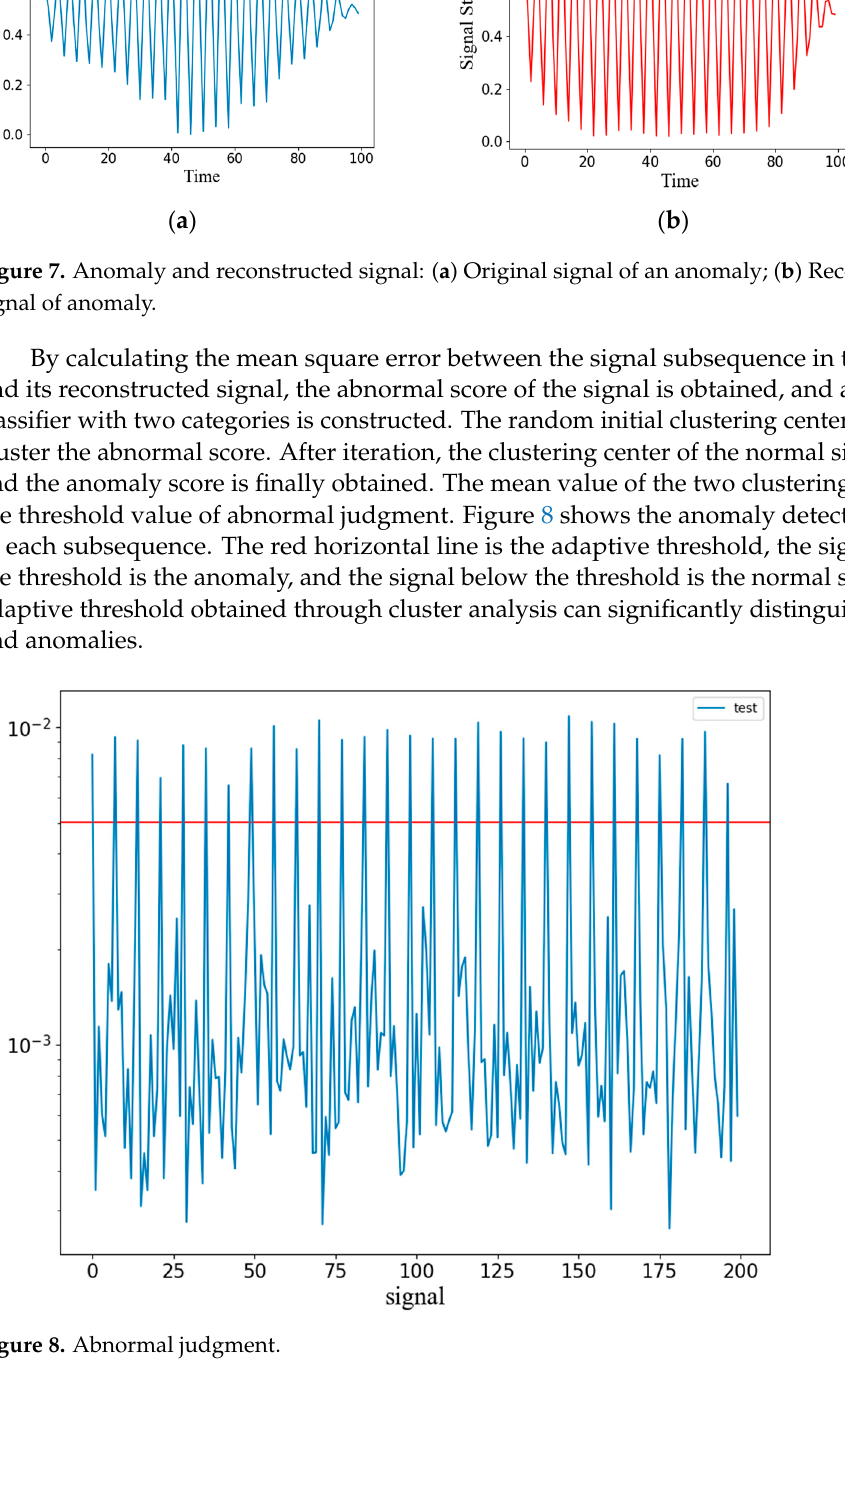
Figure 6. Model testing algorithm flow.